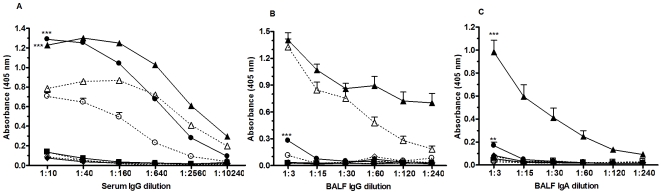
Kinetics of PR8 influenza-specific antibody response following infection in mice treated with PCN (filled symbols) or PBS (clear symbols) prior to infection.PR8 influenza-specific antibody levels were measured on day 0 (square symbol), day 5 (diamond symbols), day 7 (circle symbols) and day 9 (triangle symbols) post-infection. A) PR8 influenza-specific serum IgG levels appear sooner and are significantly enhanced in PCN-treated mice relative to the PBS-treated control mice; ***, P<0.0001. B and C) PR8 influenza-specific IgG and IgA levels appear sooner and are more intense in the BALF of PCN-treated mice following infection; **, P = 0.0002; ***,P<0.0001.